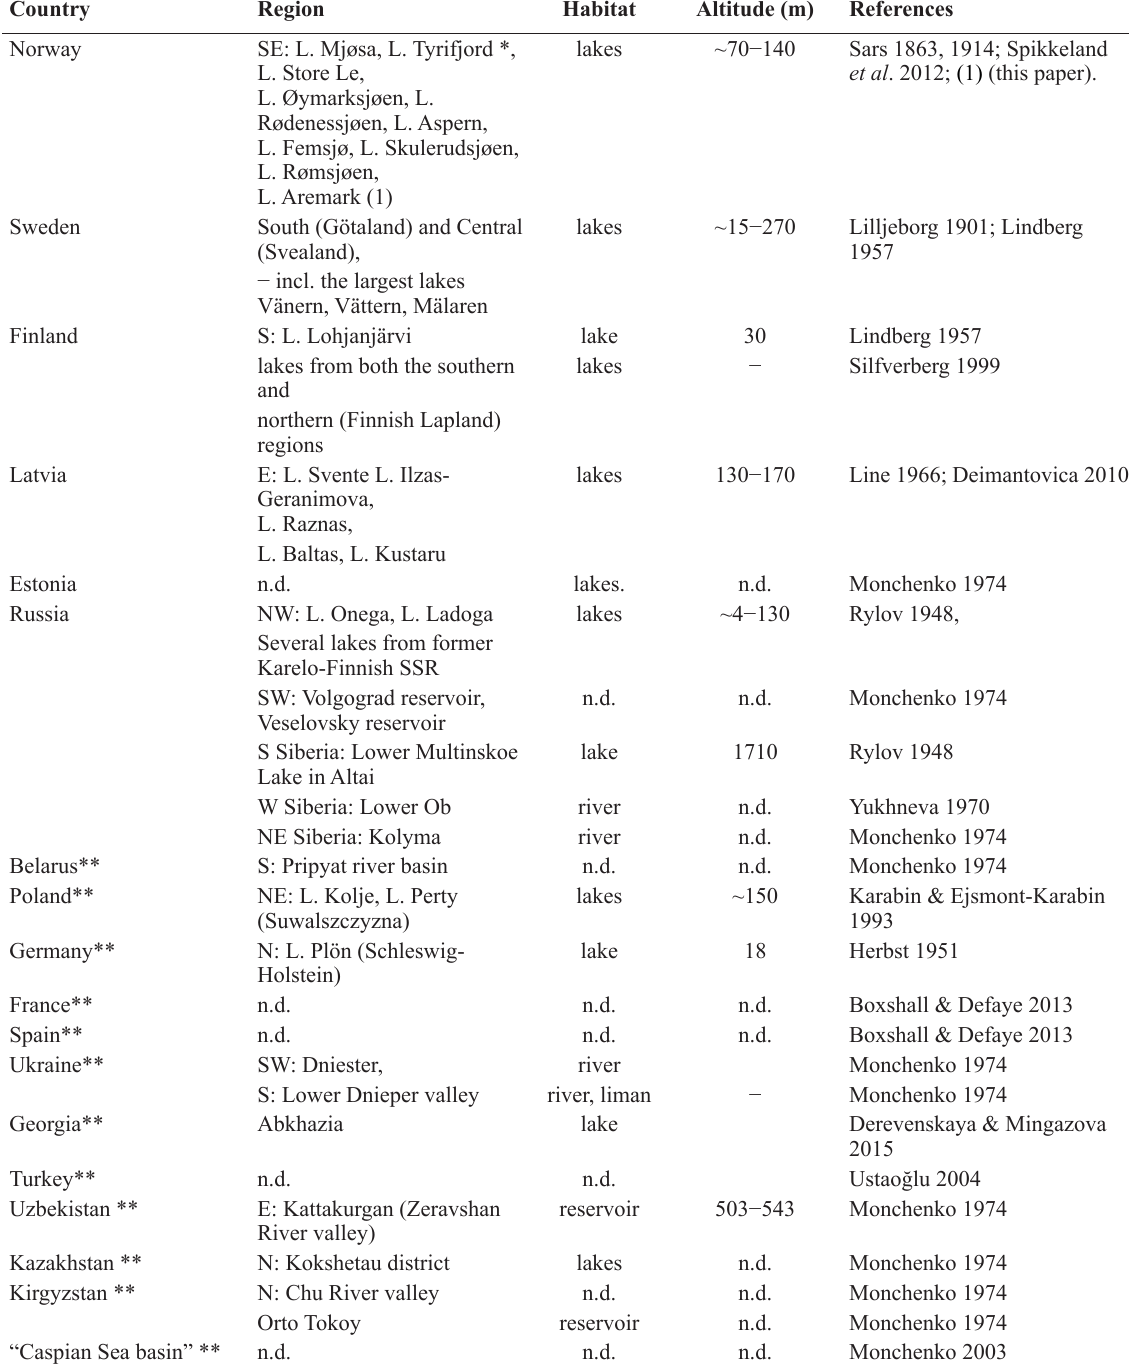
Table 5. overview of the published records of Cyclops lacustris G.o. sars, 1863, including the forms C. l. suecicus Lindberg, 1957 and C. l. finlandicus Lindberg, 1957. For comments on the data see “Discussion”. * = there are no recent records of the species; ** = records that need further